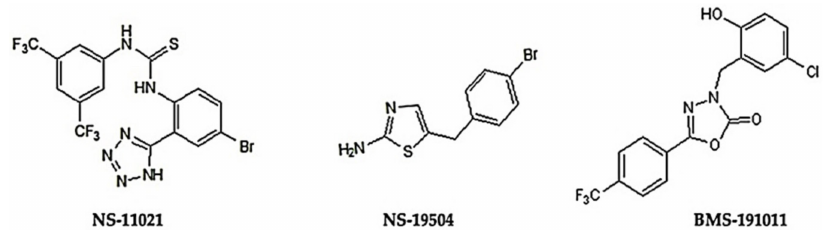
Figure 1. Chemical structures of tested BK channel openers.